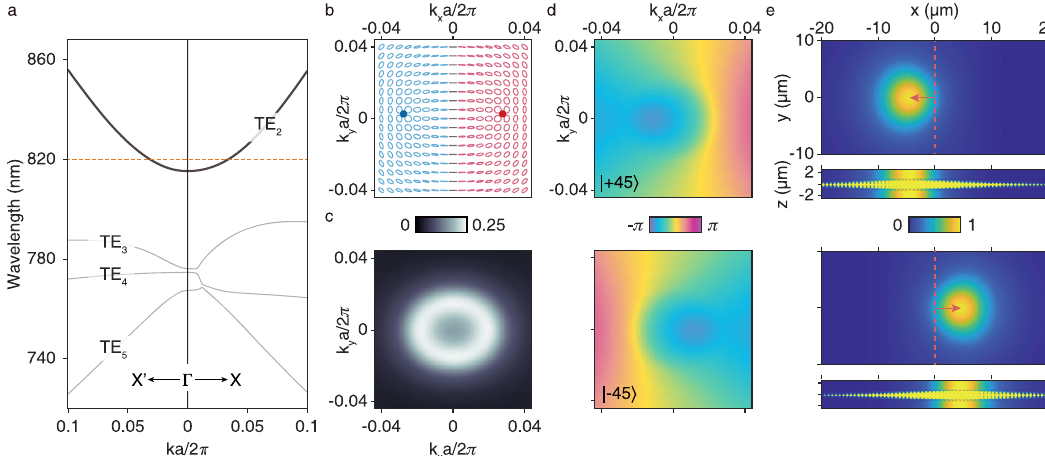
Fig. 2 Simulation results of the PhC slab applied to realize polarization-dependent lateral shifts. a Simulated transverse-electric-like (TE-like) band structure along the Γ -X and Γ -X' direction. The band we focus on is the second TE-like band (TE 2 ), marked by the solid line. We apply this band to realize lateral shift of a normally incident Gaussian beam, in which we take 820 nm as the operating wavelength marked by the orange dashed line. b Simulated structure of polarization eigenstates of band TE 2 in the vicinity of the Γ point. The red (blue) color corresponds to right-handed (left-handed) polarization eigenstates. The red (blue) dots correspond to right-handed (left-handed) circular polarized point. c Simulated wave-vector-dependent cross-polarized conversion ef fi ciency between ± 45 j i polarization states for transmitted light at 820 nm. d Simulated wave-vector-dependent phase distribution induced by the ± 45 j ( z = − 1.5 μ m) and cross-section ( y = 0 μ m) view of the realized lateral shifts at 820 nm by simulation. The normally incident Gaussian beam is centered at ( x = 0, y = 0). Only the outgoing beams with converted polarization states are shown by applying analyzing Jones matrices of (cid:4) 45 h j to the simulated fi elds. The color map is normalized according to the maximal intensity of the beam, making the color of the fi eld inside the slab which is enhanced by the guided resonances saturated. To be clear, we mark out the positions of maxima of the shifted beams instead of the centroids. The order of plots are the same as the one of d